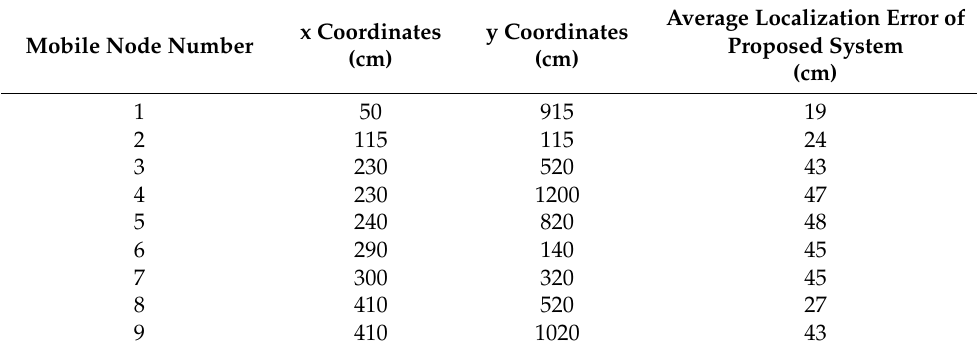
Table 1. Accuracy of localization at each